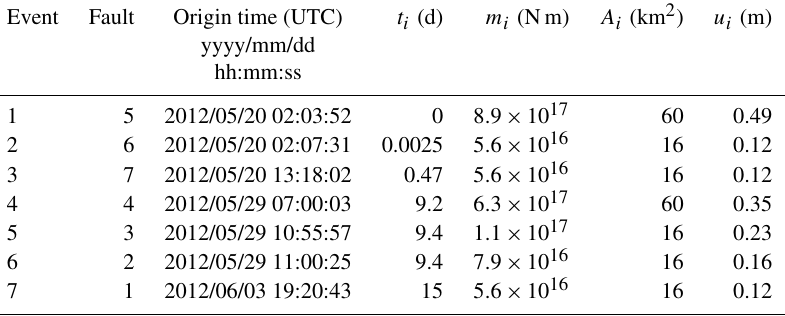
Table 1. Data for the seismic events of the 2012 Emilia sequence. The origin times and the seismic moments m i are taken from Pezzo et al. (2013) and Tramelli et al. (2014), respectively. The areas A i take into account the analysis of Caporali and Ostini (2012) and Serpelloni et al. (2012). Fault slips u i are calculated from m i and A i . See Fig. 6 for fault numbers. Event Fault Origin time (UTC) t i